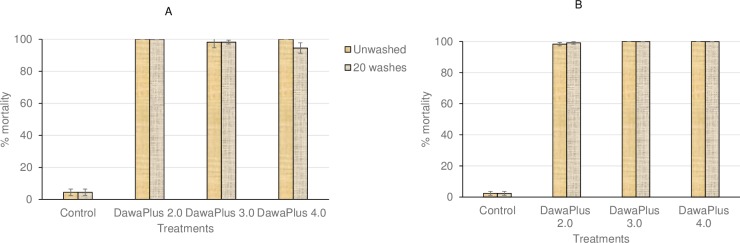
Mortality of An. gambiae Kisumu strain performed in situ on the nets using WHO cones. Bars show mortality rates at the beginning of the trial (A) and at the end (B) of the trial with unwashed and 20-times washed nets. Error bars represent 95% confidence intervals.